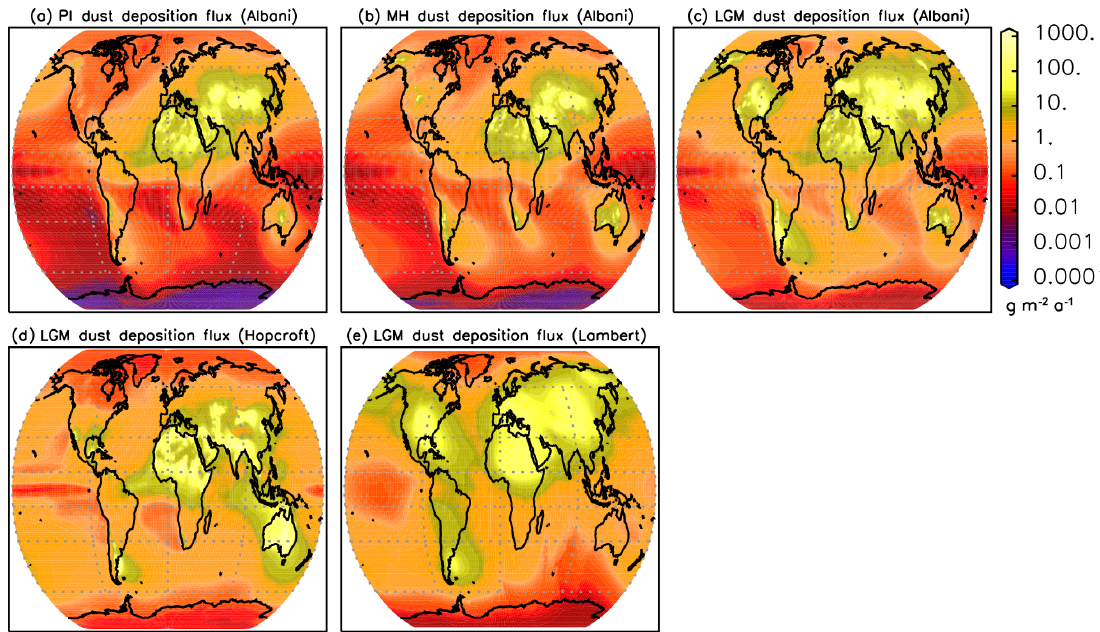
Figure 3. Maps of dust deposition (gm − 2 a − 1 ) simulated with the Community Earth System Model for the (a) PI (pre-industrial; Albani et al., 2016), (b) MH (mid-Holocene; Albani et al., 2015), and (c) LGM (Last Glacial Maximum; Albani et al., 2014). Maps of dust deposition (gm − 2 a − 1 ) for the LGM, (d) simulated with the Hadley Centre Global Environment Model 2-Atmosphere (Hopcroft et al., 2015), and reconstructed from a global interpolation of palaeodust data (Lambert et al.,